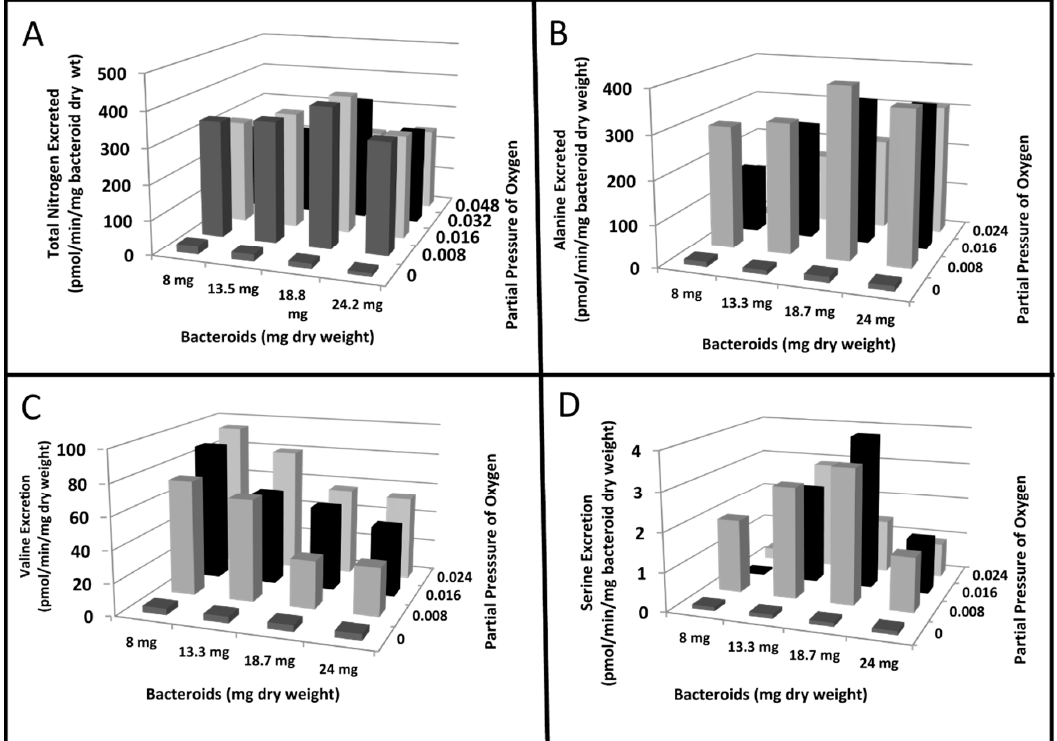
Figure 6. The bacteroid density and oxygen partial pressure landscape of nitrogen compounds transported from ex planta B . diazoefficiens bacteroids. ( A ) Total nitrogen compounds excreted. Variation of the means among duplicates was ≤ 18.3%. ( B ) Alanine excreted. Variation of the means among duplicates was ≤ 14.8%. ( C ) Valine excretion. Variation of the means among duplicates was ≤ 13.0%. ( D ) Serine excretion. Variation of the means among duplicates was ≤ 15.3%. Each column color represents a set of measurements at the same partial pressure of oxygen. All assays contained 2 mM L -malate. Each assay was performed in duplicate as described in Section 4. The experiment shown is representative of fourteen independent experiments each with different ranges of bacteroid densities, partial pressures of oxygen and concentrations of L -malate.